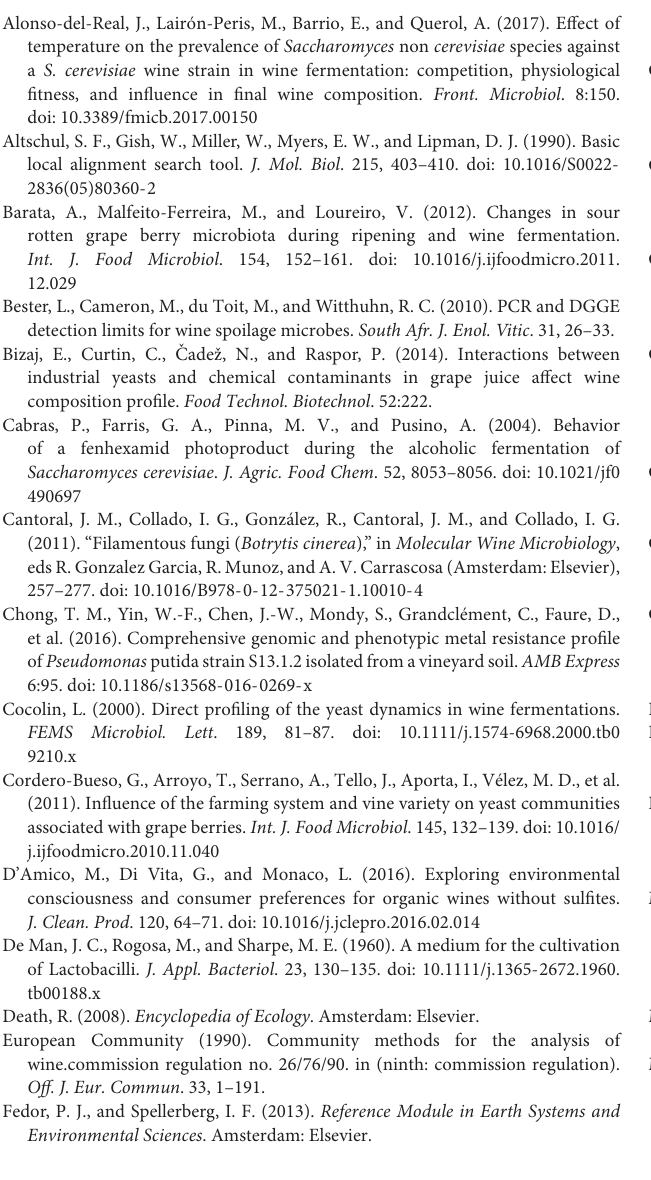
FIGURE S3 | Some of the NL1-LS2 primers amplicons species detected by DGGE in control replicates (C1, C2, C3, and C4), in samples form biofungicide treatment (B1, B2, B3, and B4) and in samples from chemical fungicide treatment (Ch1, Ch2, Ch3, and